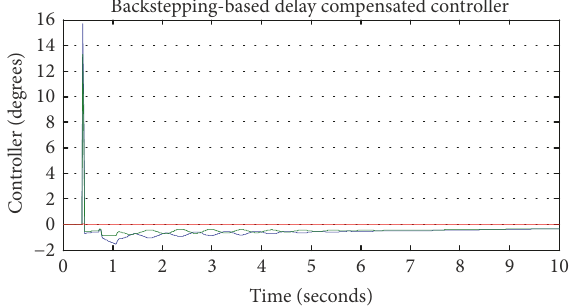
Figure 4: Compensated actuator deflections.